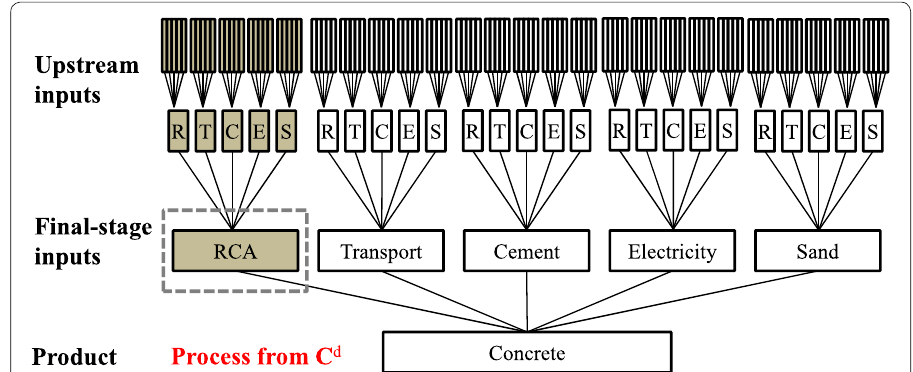
Fig. 9 Recycled concrete aggregate (RCA) contribution in the decomposition of LCIs by final - stage